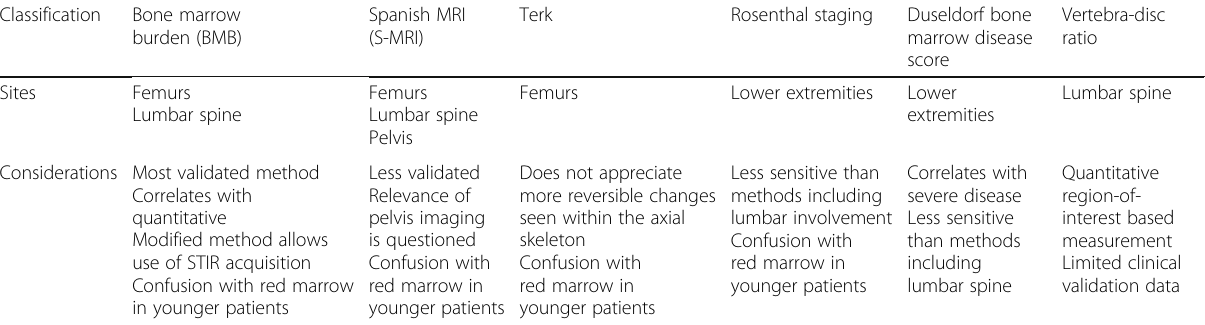
Table 5 Semi-quantitative Gaucher disease bone marrow involvement scoring systems Classification